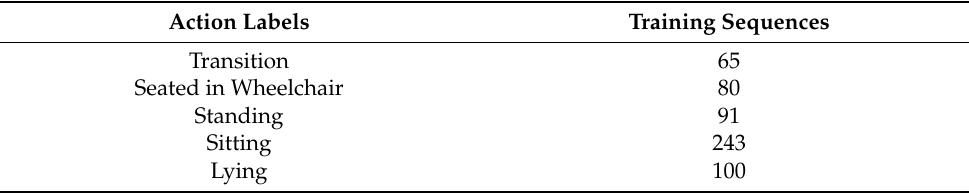
Table 3. Number of training sequences for five action labels.